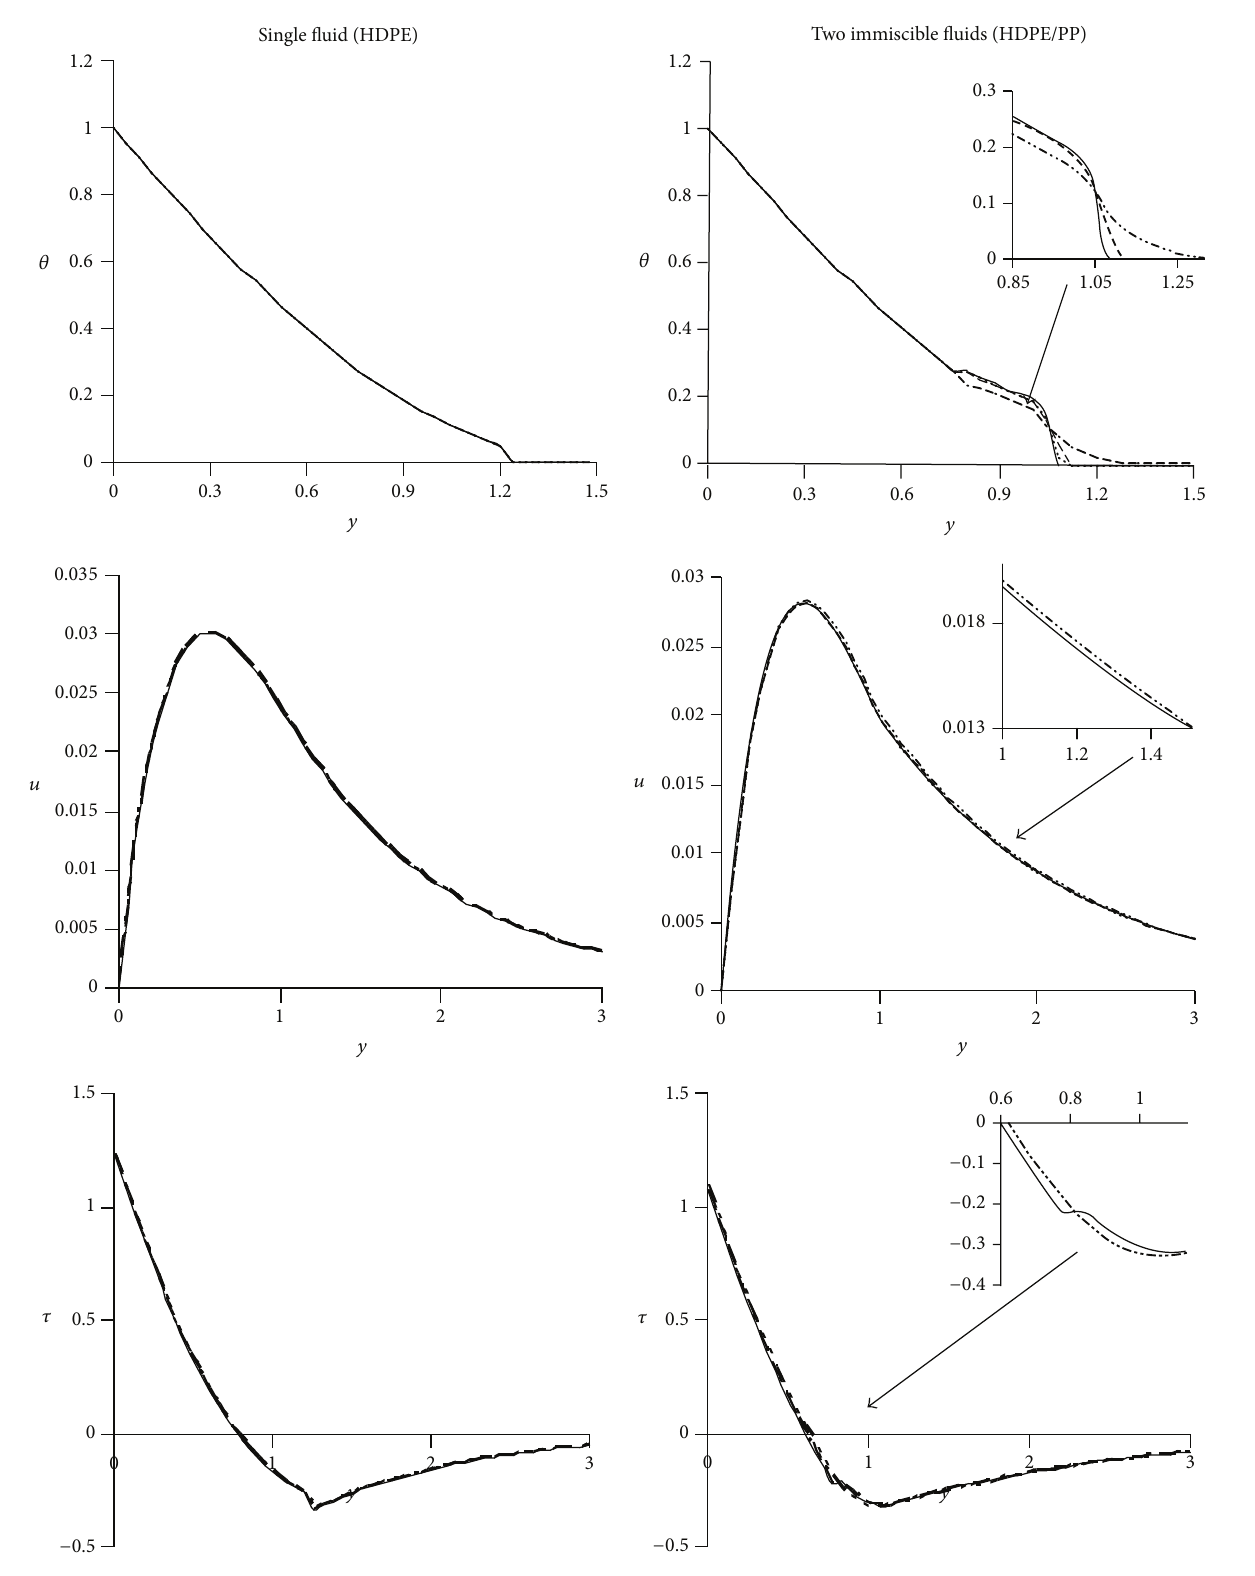
Figure 3: Temperature, velocity, and stress distribution for 𝛼 1 = 𝛽 1 = 𝛽 2 = 1 , 𝑡 = 0.09 , and 𝛼 2 = { 0.0 (– ⋅ ⋅ –); 0.8 (–––); 0.9 ( ⋅ ⋅ ⋅ ); 1.0 (— )}